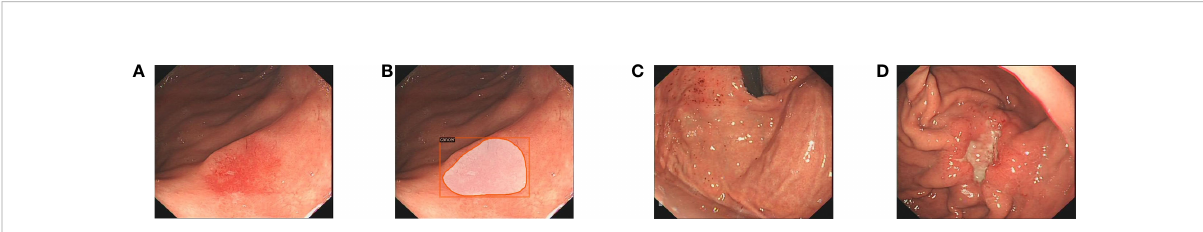
FIGURE 1 The endoscopists and the Mask R-CNN system delineate the lesion in WLI. (A) The EGC lesion in WLI. (B) The Mask R-CNN system delineates the EGC lesion. (C) Gastritis in WLI. (D) The AGC lesion in WLI. WLI, white light imaging; Mask R-CNN, mask region-based convolutional neural network; EGC, early gastric cancer; AGC, advanced gastric